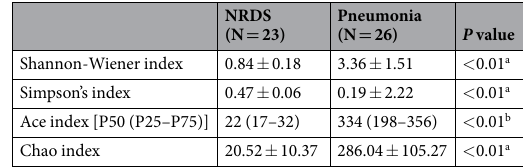
Table 4. Comparison of microbial diversities of endotracheal tube biofilm flora of the study samples achieved from NRDS and pneumonia patients in the study. a Based on adjusted t-test. b Based on Mann–Whitney U